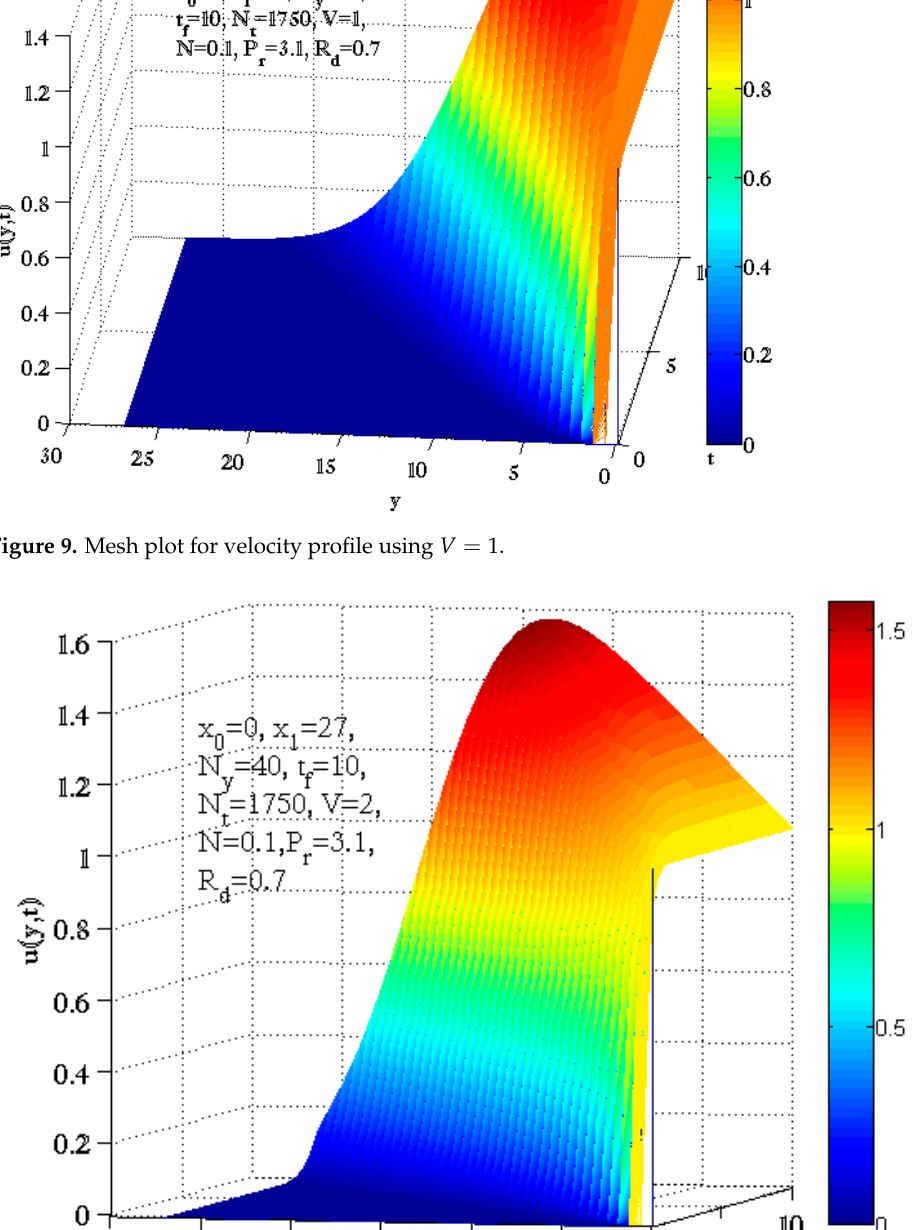
Figure 10. Mesh plot for velocity profile using (cid:1848) = 2